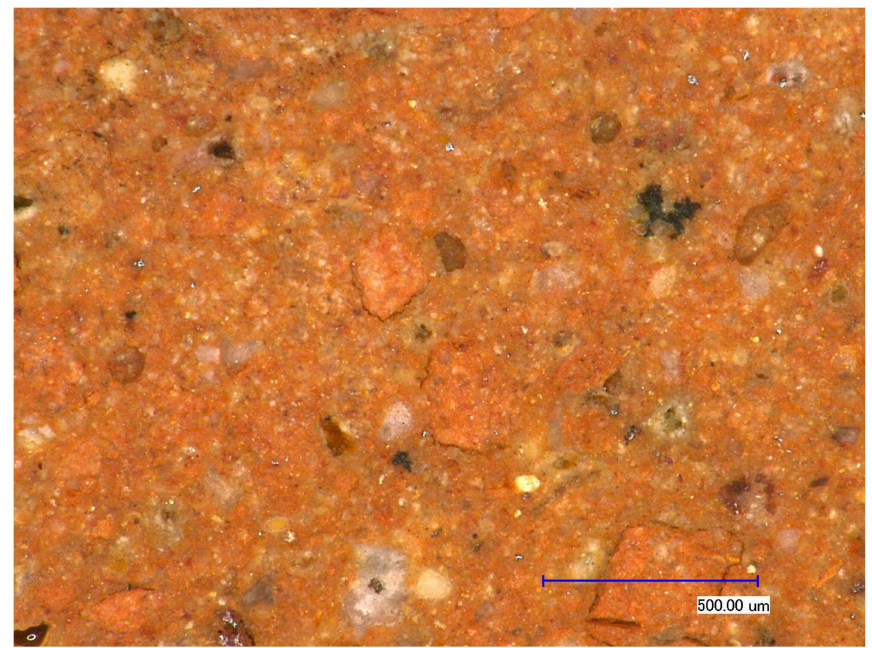
Figure 2. Micrograph of sample M15 (I.13/69.13A1).